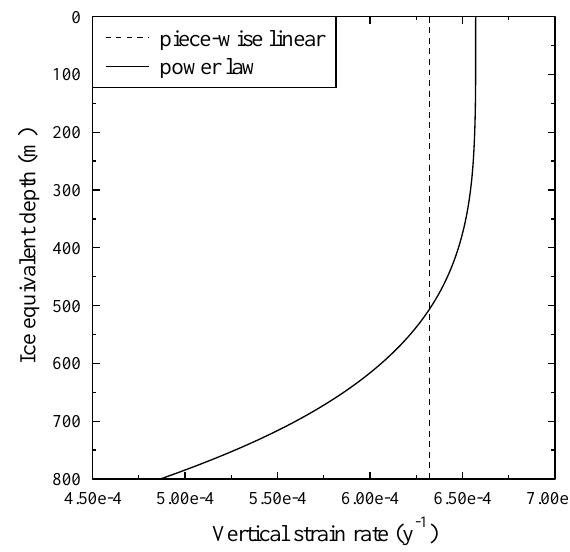
Figure 6. Vertical strain rates from the piece-wise linear and power- law models which were calculated using the annual layer thickness